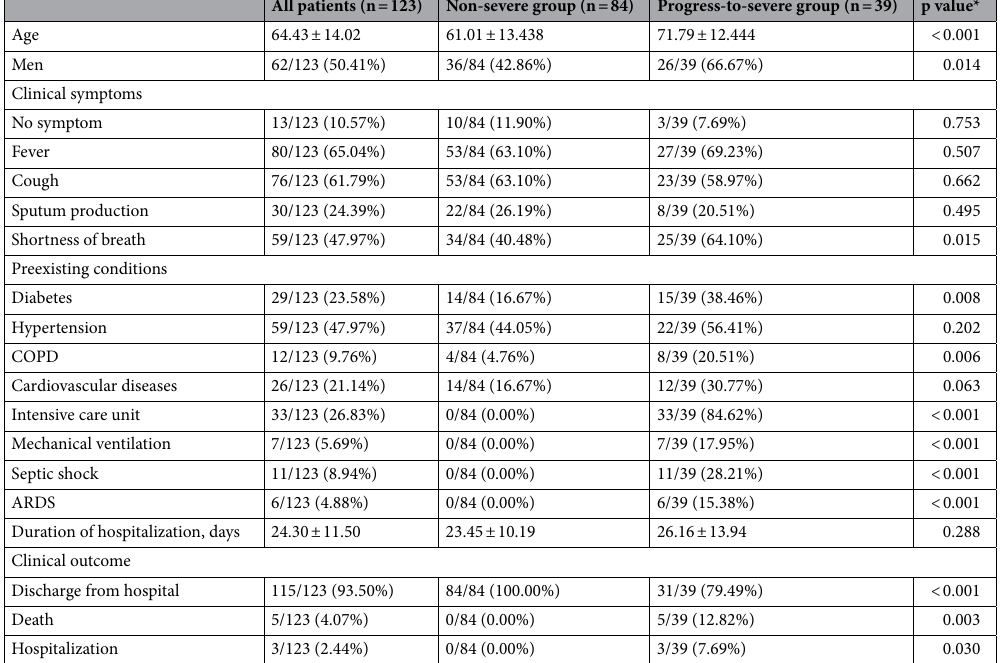
Table 1. Demographic and clinical characteristics of the patients. ARDS acute respiratory distress syndrome, COPD Chronic obstructive lung disease.